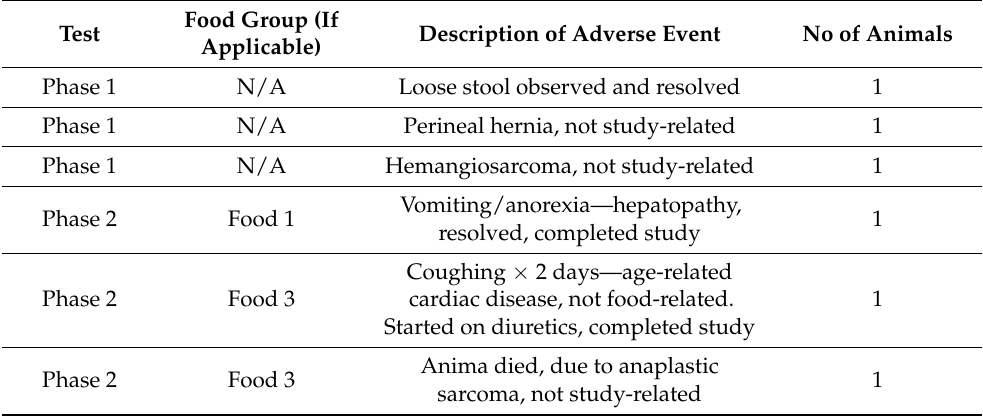
Table 2. Adverse events are summarized below. (Control, Food 1, Food 2 and Food 3 have 0 ppm, 75 ppm, 150 ppm and 300 ppm of a-LA